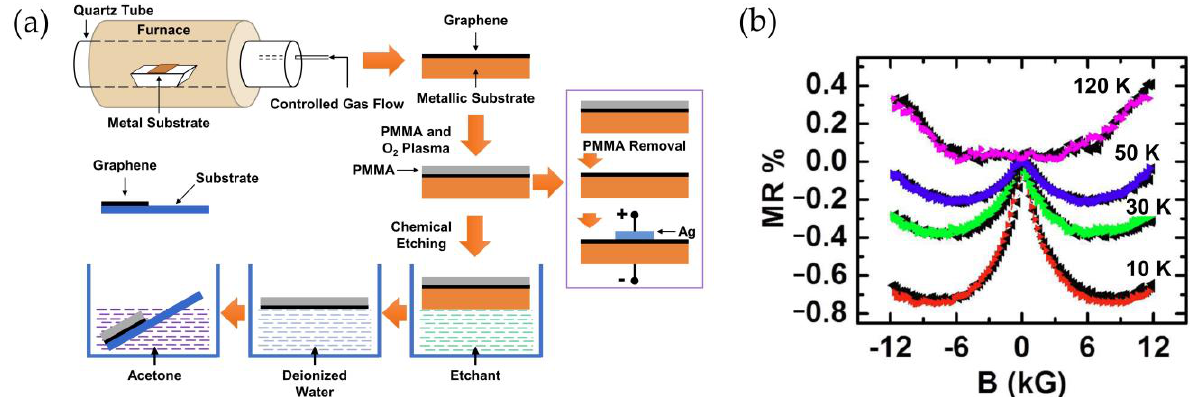
Figure 7. ( a ) Schematic diagram of the fabrication process of multilayer graphene/metal catalyst heterojunction. ( b ) MR of the re- sponse of multilayer graphene on Cu substrate. Adapted from [ 88 ] . Figure Copyright © 2013 MDPI Publishing, Open Access.